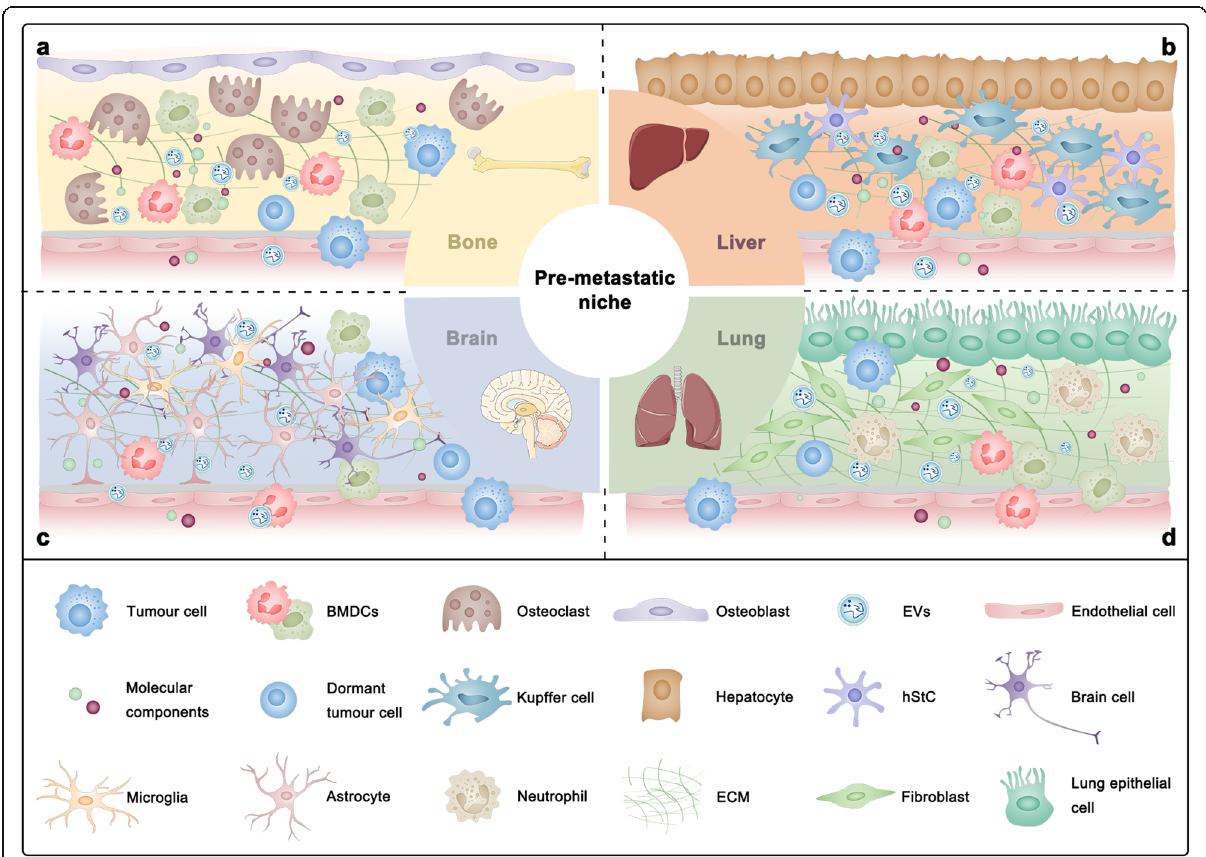
Fig. 2 Different characteristics of organ-specific microenvironments determine metastatic organotropism. a Bone tropic metastasis. The bone microenvironment formed by osteoblasts, osteoclasts, or other cells promotes bone-specific metastasis. b Liver tropic metastasis. Hepatic metastasis is determined by the interactions between tumour cells and different resident subpopulations, including hepatocytes, hepatic stellate cells (hStCs) and Kupffer cells. c Brain tropic metastasis. Tumour cells colonizing the brain need to overcome the defence provided by the blood- brain barrier (BBB) and immune cells including astrocytes and microglia. d Lung tropic metastasis. Tumour cells can reprogram lung stromal cells, including lung fibroblasts and epithelial cells, which in turn contributes to pulmonary